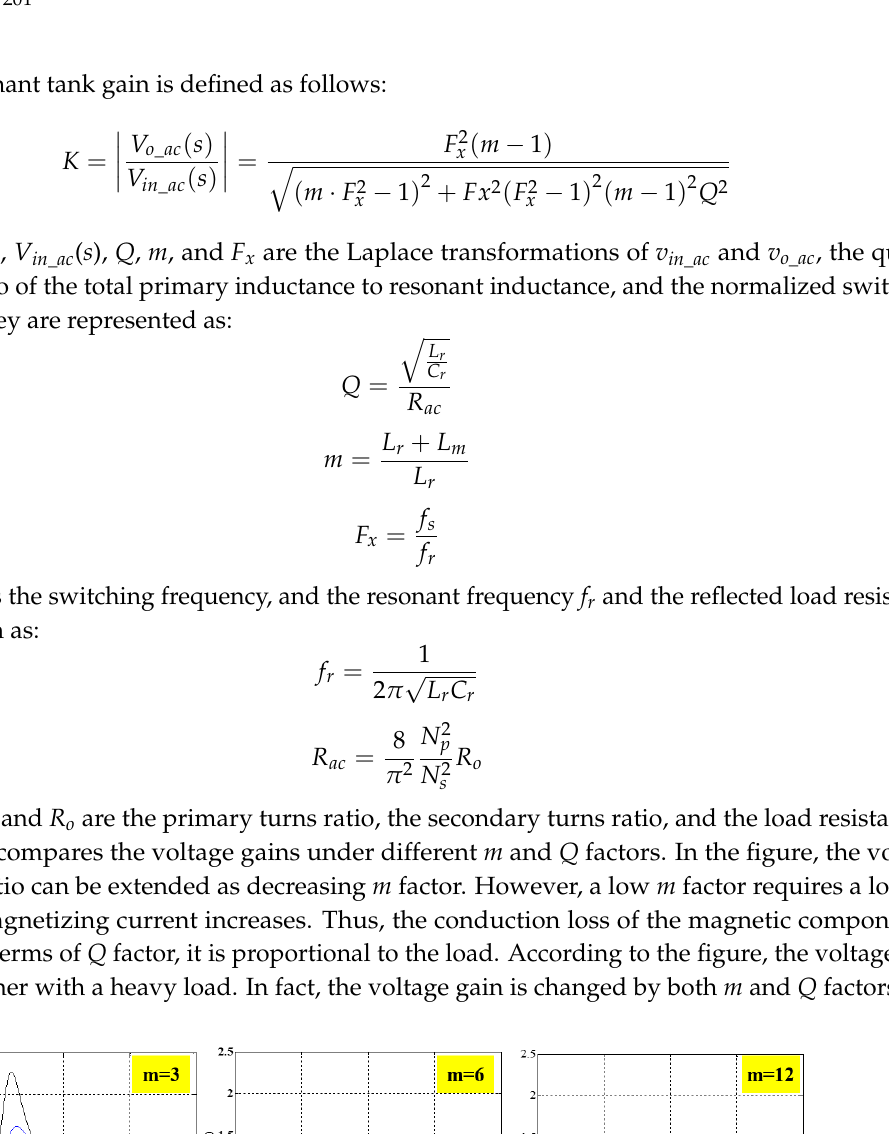
Figure 8. Equivalent resonant circuit [36].